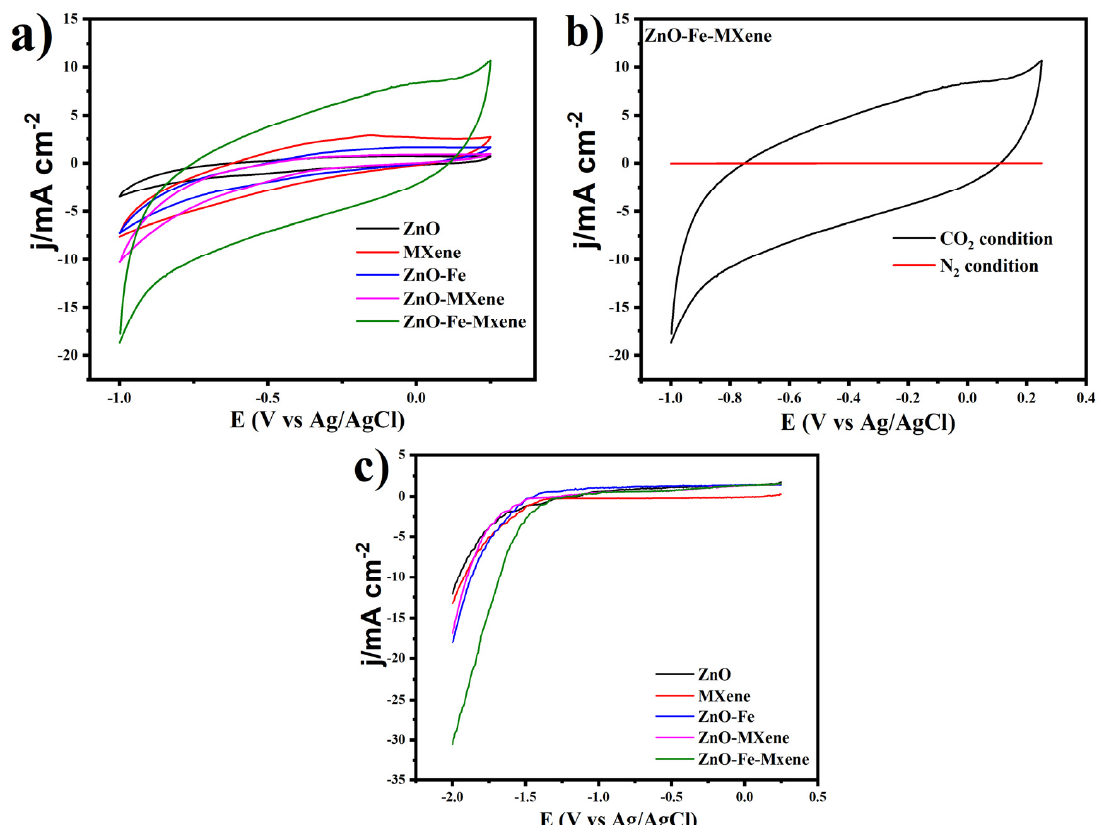
Figure 4. Cyclic voltammetry (CV) studies of the ( a ) ZnO, MXene, ZnO-Fe, ZnO-MXene, and ZnO-Fe-MXene nanocomposites in a CO 2 saturated aqueous solution of 0.5 M NaOH at a scan rate of 50 mV/s; and ( b ) ZnO-Fe-MXene nanocomposite under CO 2 and N 2 conditions. ( c ) Linear sweep voltammogram studies of the ZnO, MXene, ZnO-Fe, ZnO-MXene, and ZnO-Fe-MXene nanocomposites at a scan rate of 50 mV/s. Table 2. Current density of prepared nanomaterials at a scan rate of 50 mV/s under CO 2 conditions. Materials